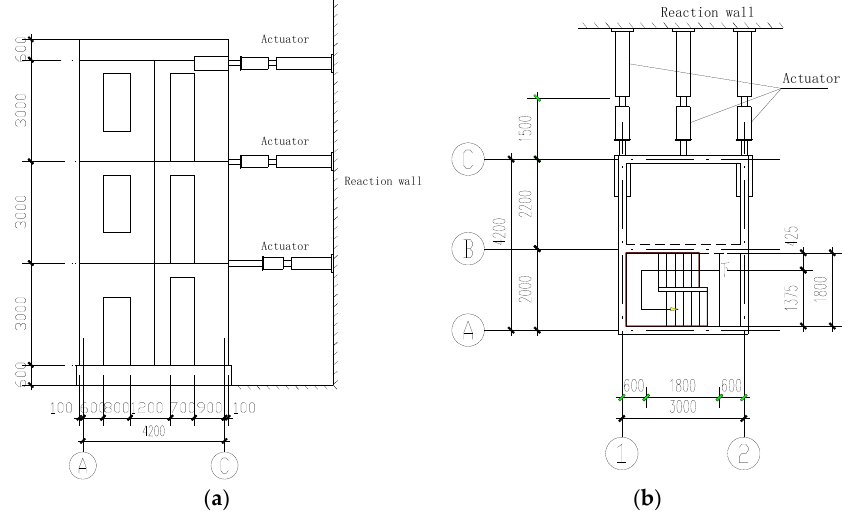
Figure 3. Planned arrangement of horizontal loading devices for the hybrid simulation testing: ( a ) elevation; ( b ) Plan view.